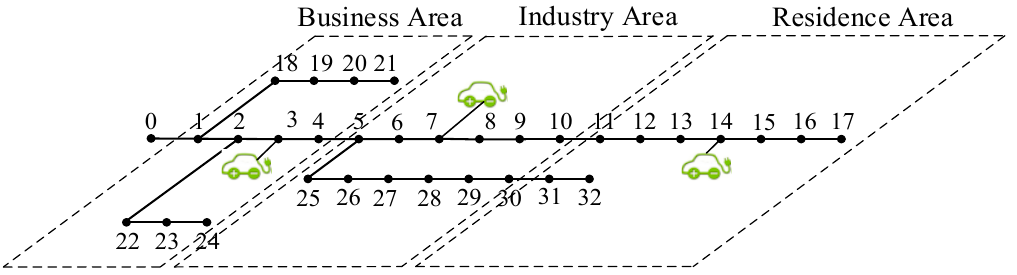
Figure 3. IEEE 33-bus system.